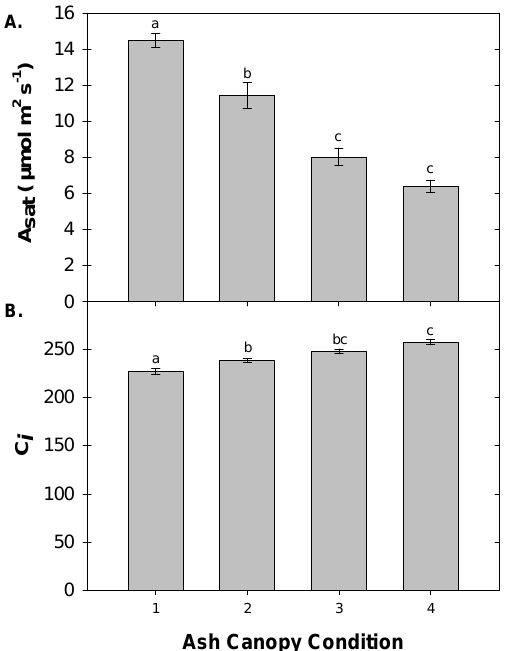
Figure 6. Mean light saturated photosynthetic rate (A sat ; at 1600 PAR; panel ( A )) and internal leaf CO 2 concentration (Ci; panel ( B )) across foliage from ash trees of different ash condition classes. Letters represent significance levels determined by Tukey’s HSD pairwise comparisons ( p < 0.05), error bars denote ±1 SE.